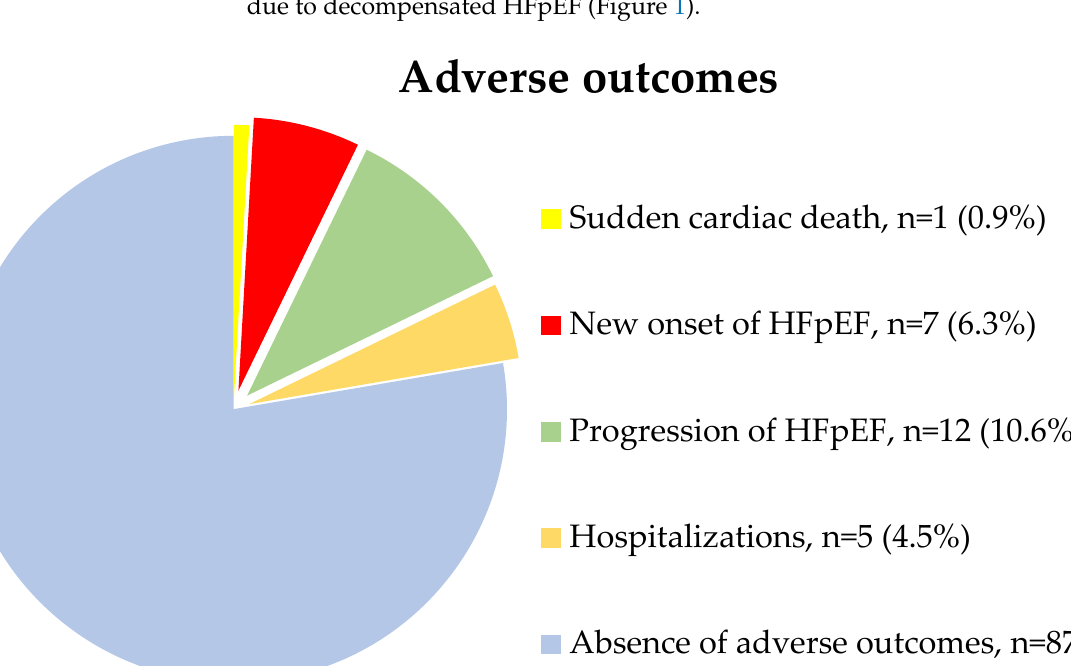
The Incidence of Adverse Outcomes Depending on the Presence of CMD (Kaplan-Meier)